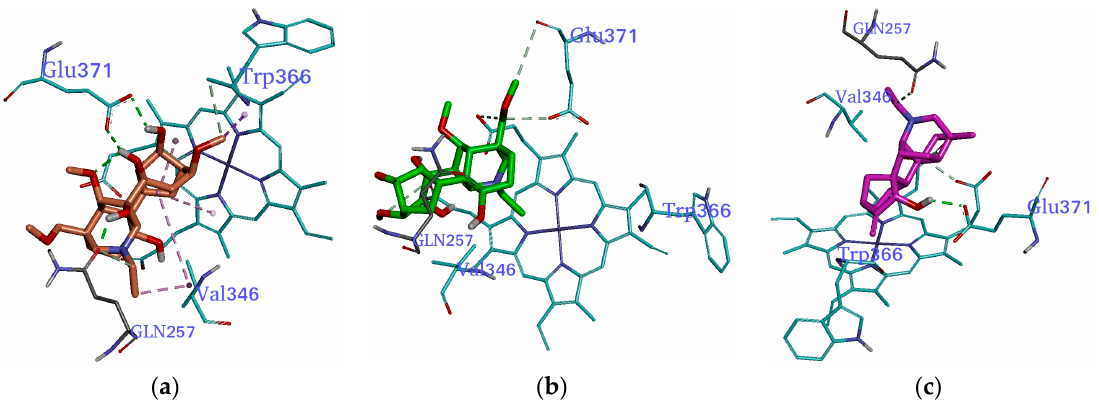
Figure 7. Interaction modes of delsoline, fuziline and songorine within iNOS binding pocket. ( a ) H-bonds between delsoline and iNOS pocket; ( b ) H-bonds between fuziline and iNOS pocket; ( c ) H-bonds between songorine and iNOS pocket.